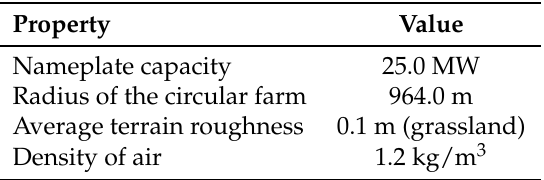
Table 1. Specified properties of the generic wind farm